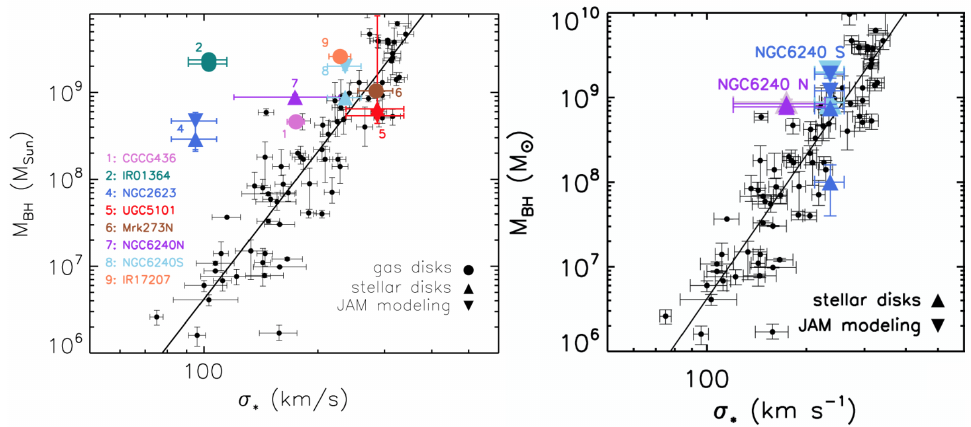
Figure 9. ( Left ) The M BH − σ relation for normal galaxies from McConnell and Ma [176] (black) and merging (U)LIRGs (colored) from different mass determination methods. (U)LIRGs appear to lie on top of or above the scaling relation. Figure from Medling et al. [167]. ( Right ) The same plot but now the black hole mass measurement for NGC 6240 has been updated to incorporate correction based on the submillimeter measurement of the gas mass. Figure adapted from Medling et al. [177]. Both panels © AAS, reproduced with